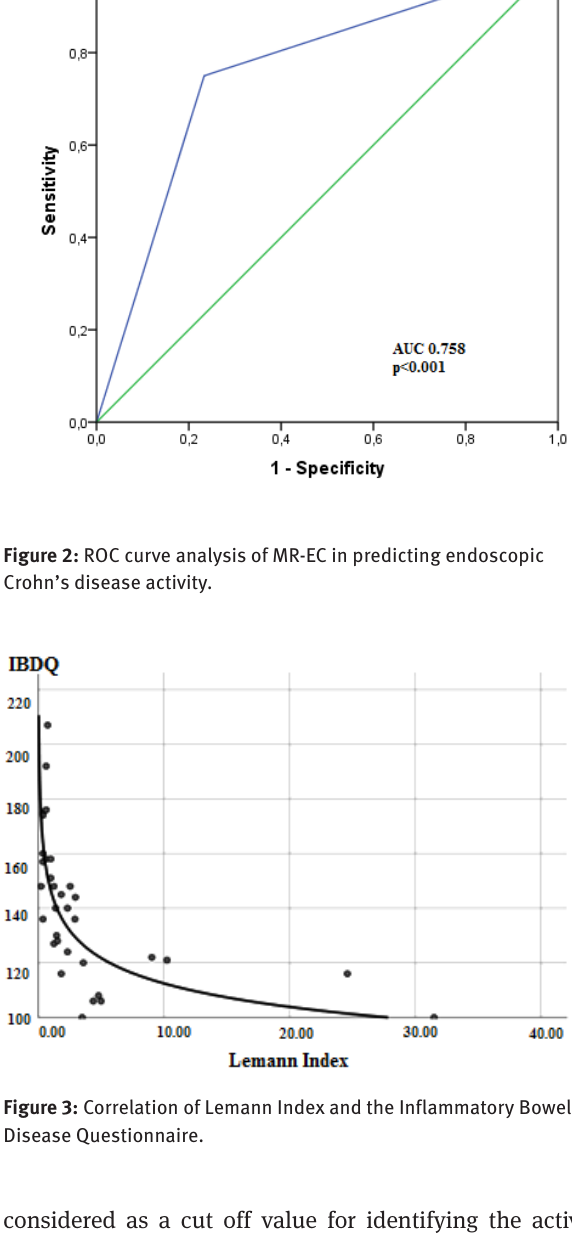
Characteristics